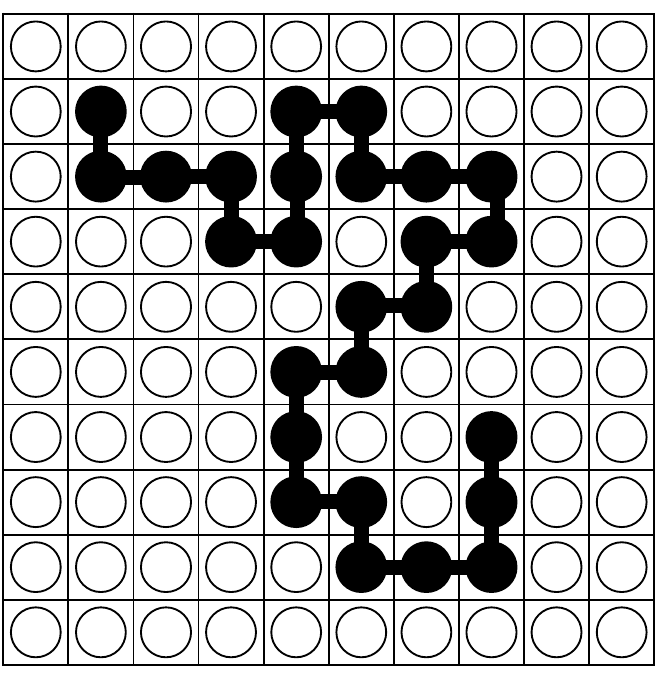
Figure 2. Random walk of a polymer chain in solute on a two dimensional lattice with coordination number four after Flory’s original drawing